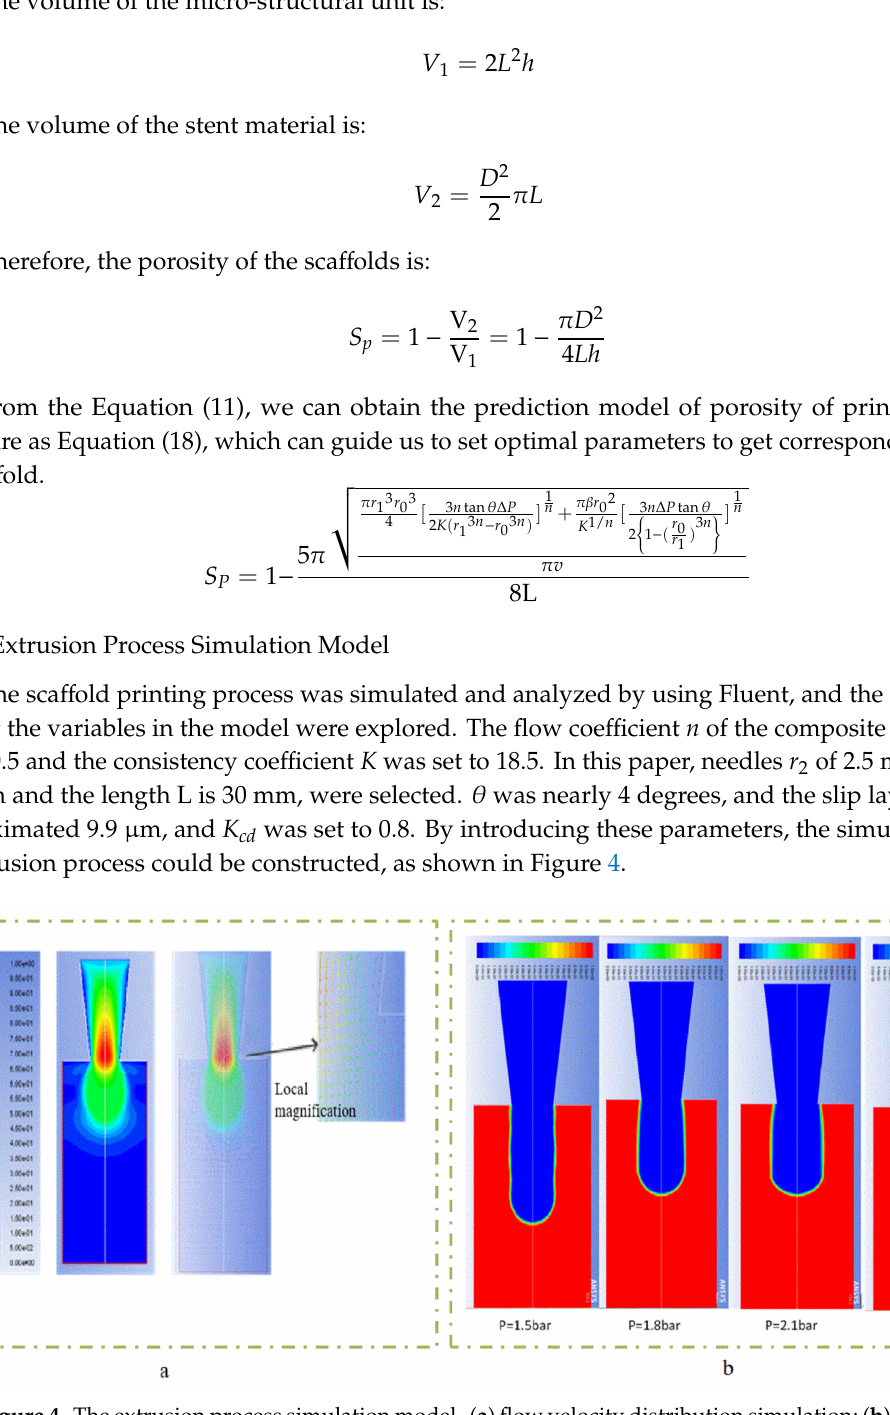
Figure 4. The extrusion process simulation model. ( a ) flow velocity distribution simulation; ( b ) di ff erent expansion under di ff erent pressure